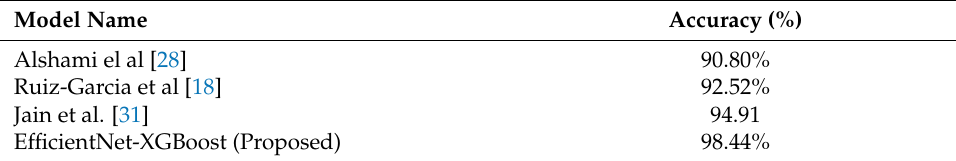
Table 8. Accuracy of KDEF